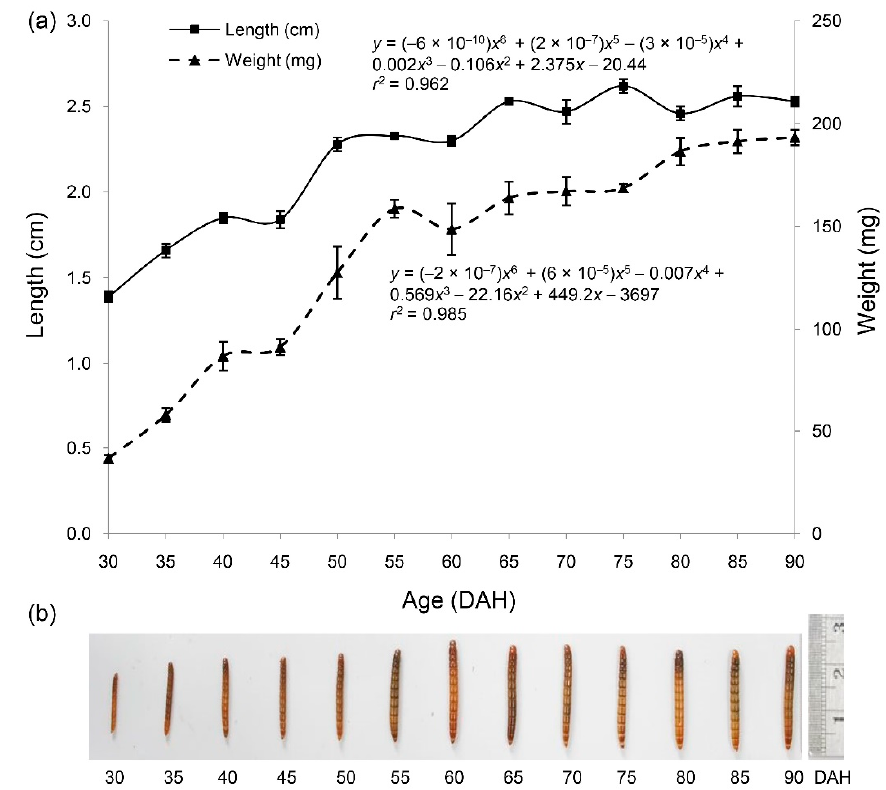
Figure 1. Ontogenic changes in body weight and length of mealworm larvae ( a ). Data are expressed as mean ± SEM from triplicate measurements ( n = 30 per sampling time). Larval body lengths at different harvesting times ( b ). DAH stands for days after hatching.